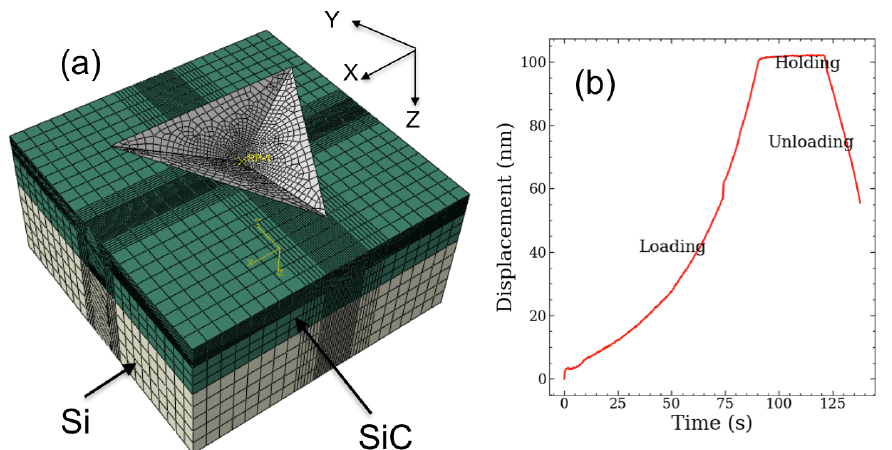
Figure 2. ( a ) Indentation model used in the present work. The model consists of a Si substrate, having a thickness of 3 µ m, and a 3C-SiC layer, having a thickness of 2 µ m. The Berkovich indenter has been modeled as discrete rigid body. ( b ) Experimental displacement vs. time profile used for applying the displacement-controlled boundary conditions in the indentation simulation.